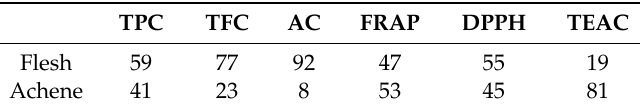
Table 1. Estimation of relative contribution (%) of total phenolic compounds (TPCs), flavonoids (TFCs) and anthocyanins (ACs) and antioxidant capacity by FRAP, DPPH and TEAC in non-digested flesh and achenes on a whole